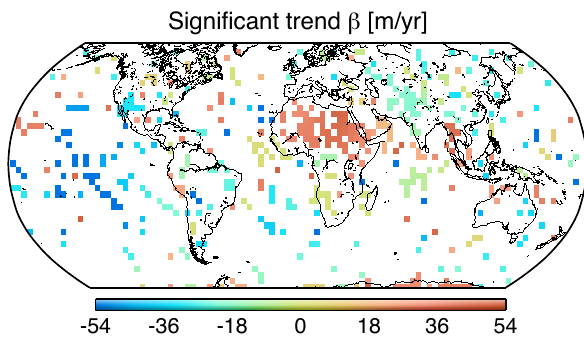
Figure 13. Global trend β in CTH anomaly, statistically significant at 95% confidence level. Data are gridded onto a mesh of 2 ◦ -sided